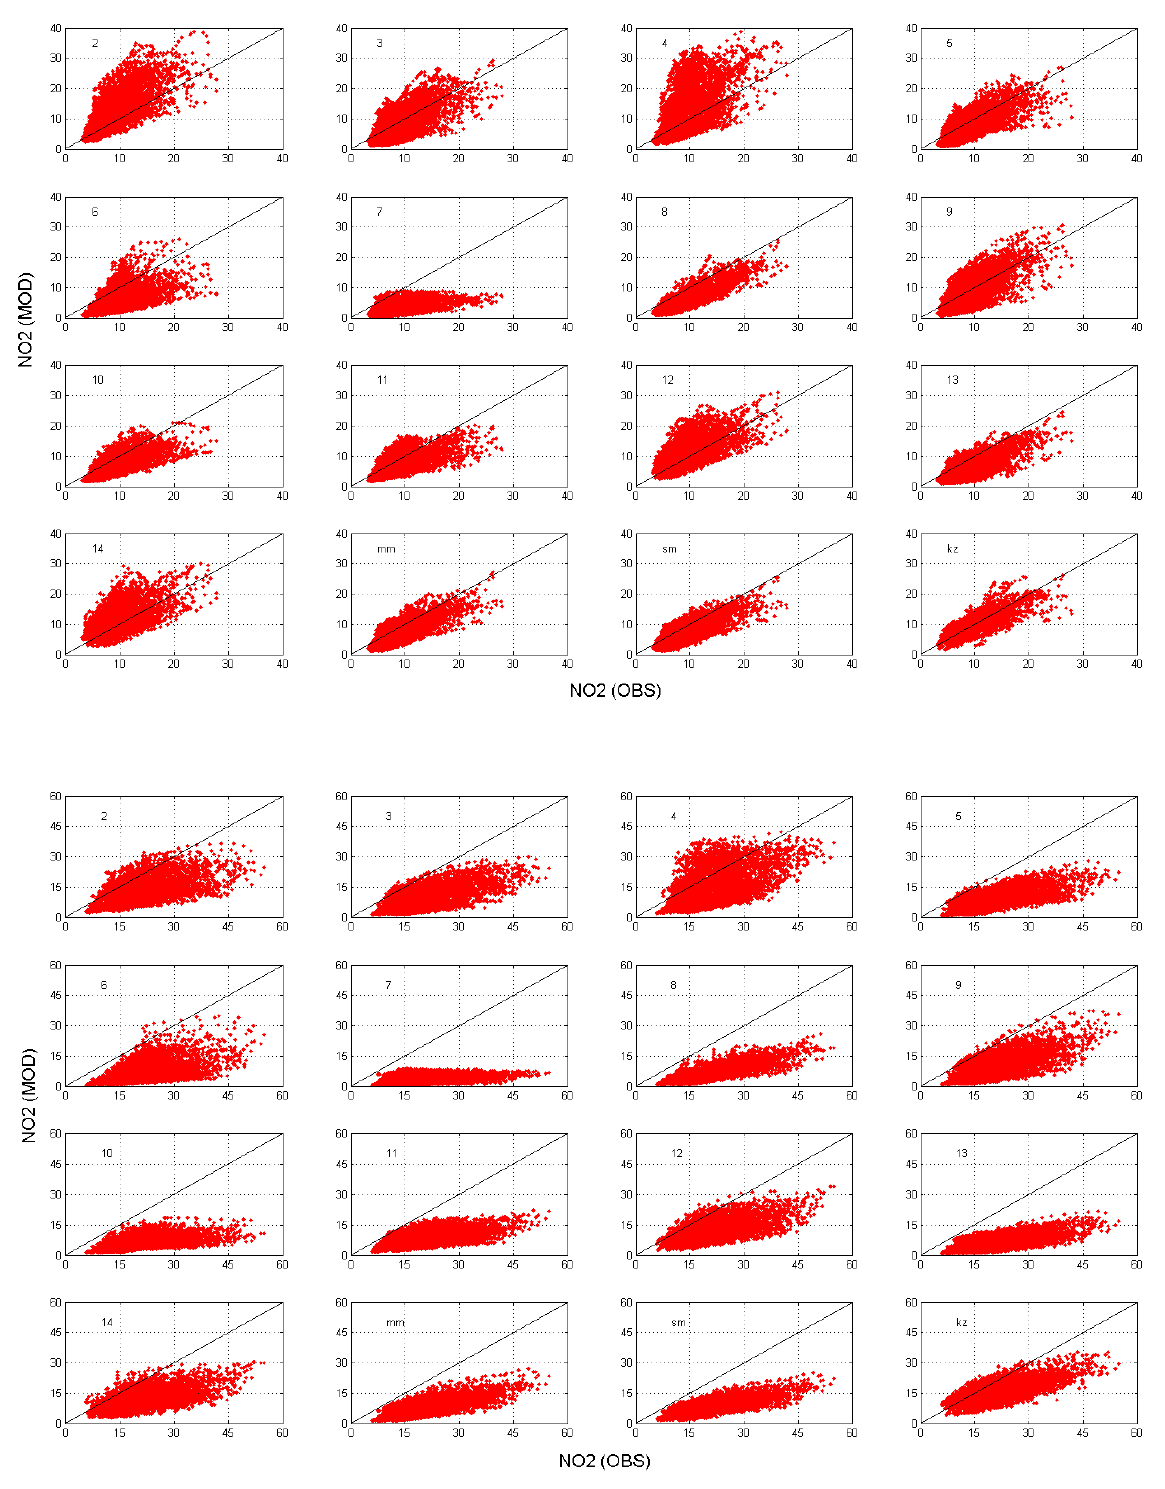
Fig. 15. Indicative results for NO 2 . Scatterplot of all examined cases corresponding to the prediction week, for the rural (top) and urban (bottom) concentrations of the EU2